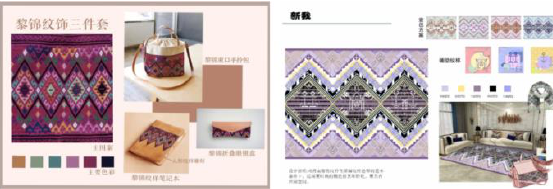
Fig. 1. Traditional Li Nationality Brocade form and works in Hainan, China